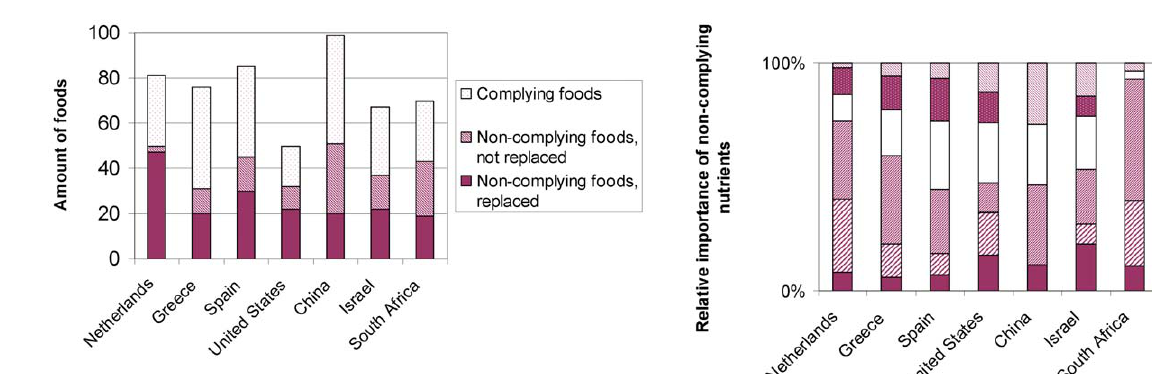
Figure 2. The amount of foods in the Typical Daily Menus. Per country it is shown how many foods complied with the Choices criteria, as well as the amount of foods that did not comply: The non-complying foods are divided in those that were either replaced, when an alternative was available on the market, or not replaced.